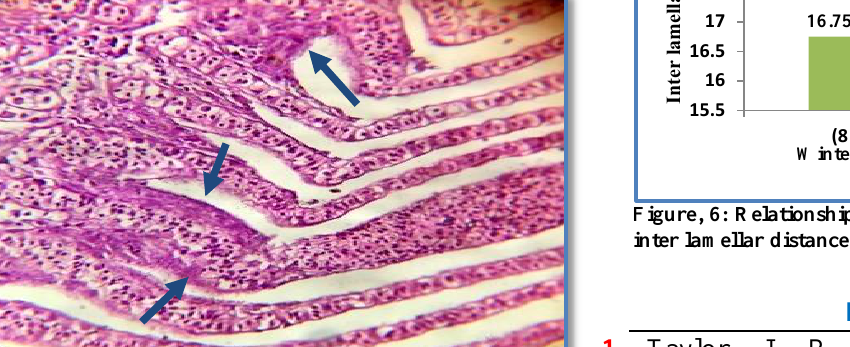
Figure, 4: Longitudinal section of filament during summer season showing thickening of lamellar epithelium ( ), (X400 H and E stain).